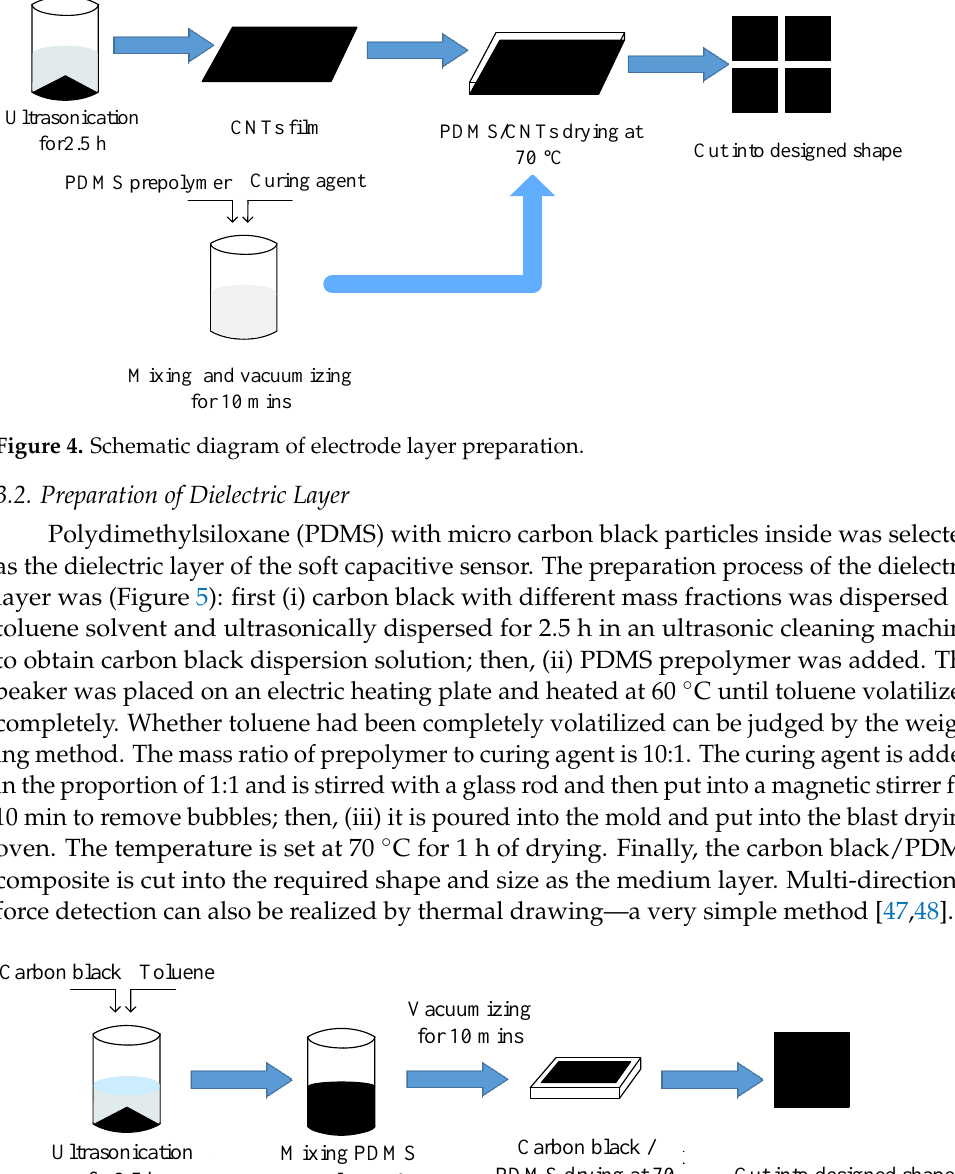
Figure 5. Schematic diagram of dielectric layer preparation.